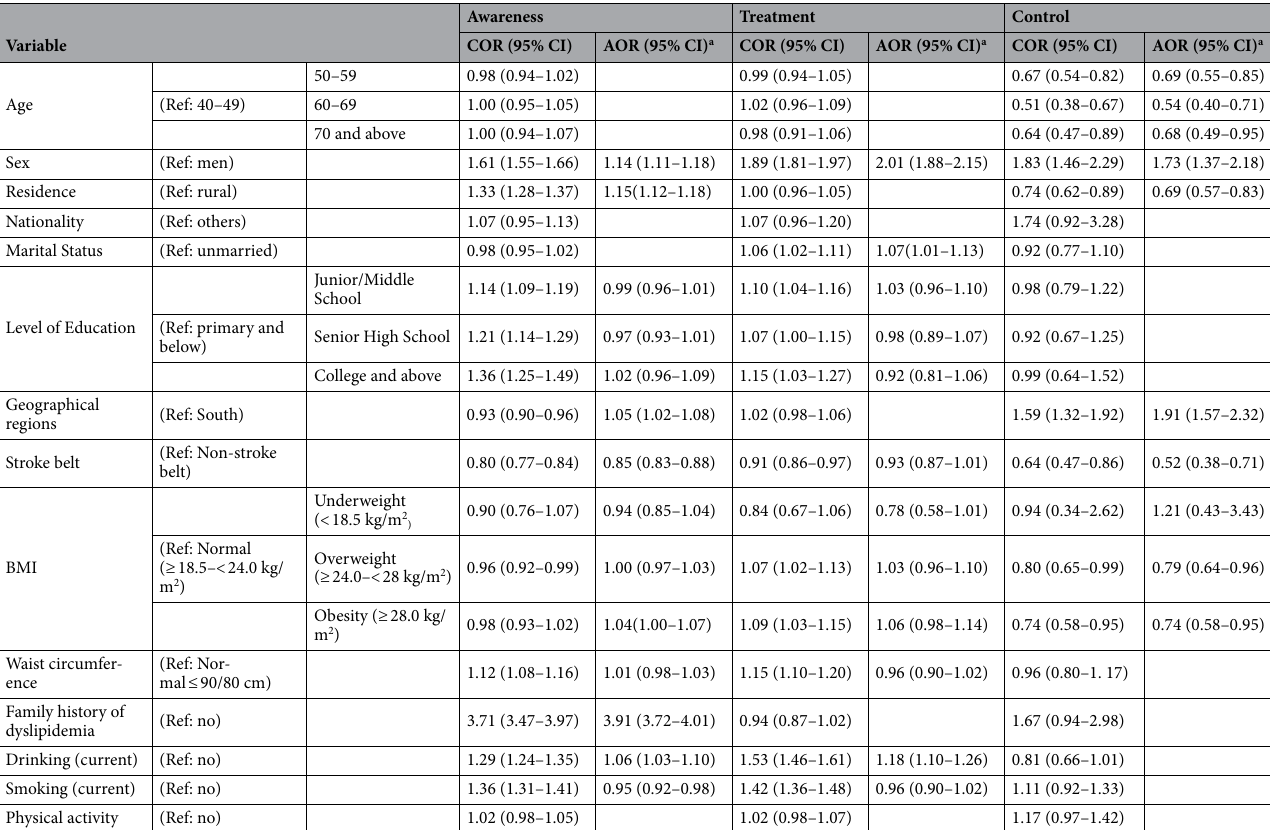
Table 3. Univariate and multivariable analyses of factors affecting awareness, treatment, and control of dyslipidemia among adults. COR Crude odds ratio, AOR adjusted odds ratio, CI confidence interval. Unmarried (widowed/divorced/others). a Adjusted for all variables cited in the